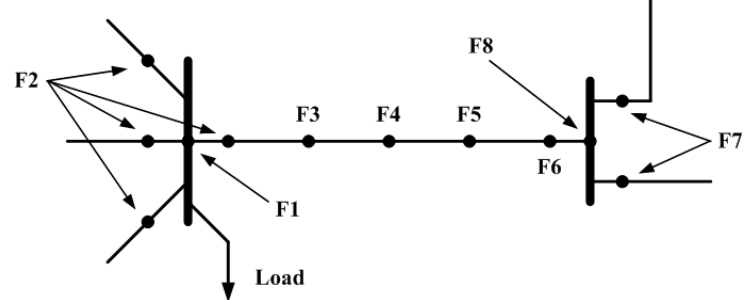
Figure 1. Part of a network with fault positions.